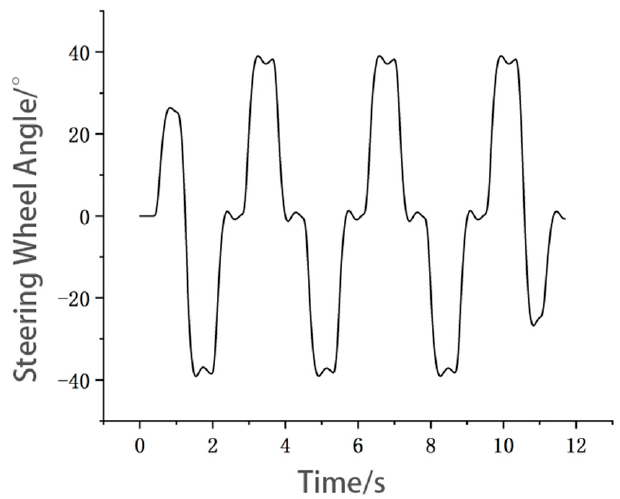
Figure 14. Input curve of steering-wheel angle in open-loop test.